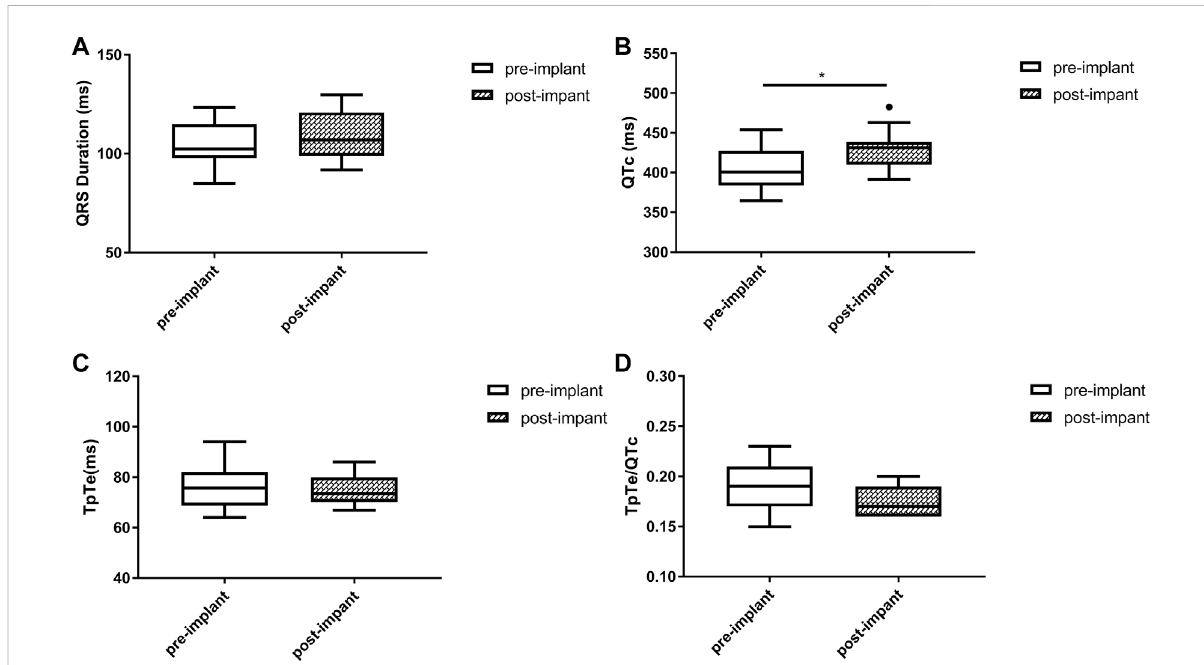
FIGURE 3 Changes in QRS duration (A) , QTc (B) , TpTe (C) , TpTe/QTc (D) before and after LBBAP in patients with baseline narrow QRS ( n = 11). (Box plots exhibited thesmallestnonoutlier, fi rst quartile, median, third quartile, and largest non-outlier of each variable from bottom to top. LBBAP